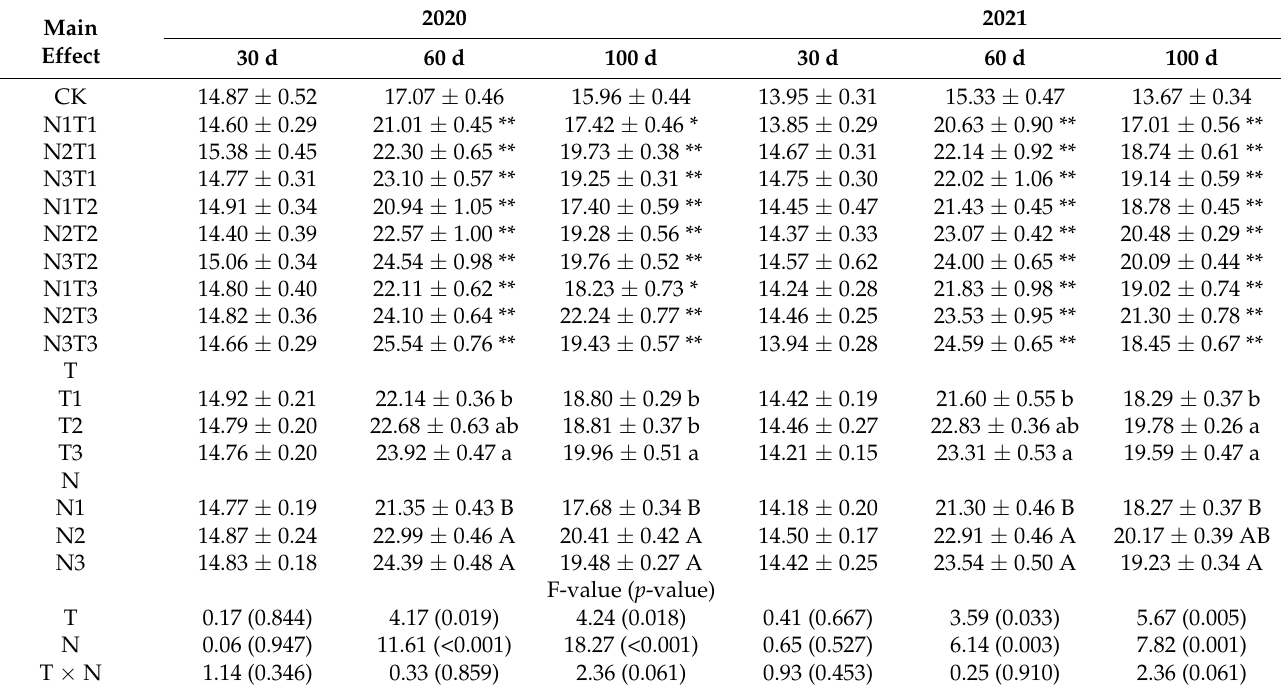
Table 7. Response of tomato net photosynthetic rate (P n , µ mol CO 2 m − 2 s − 1 ) to different urea types and N application rates in the